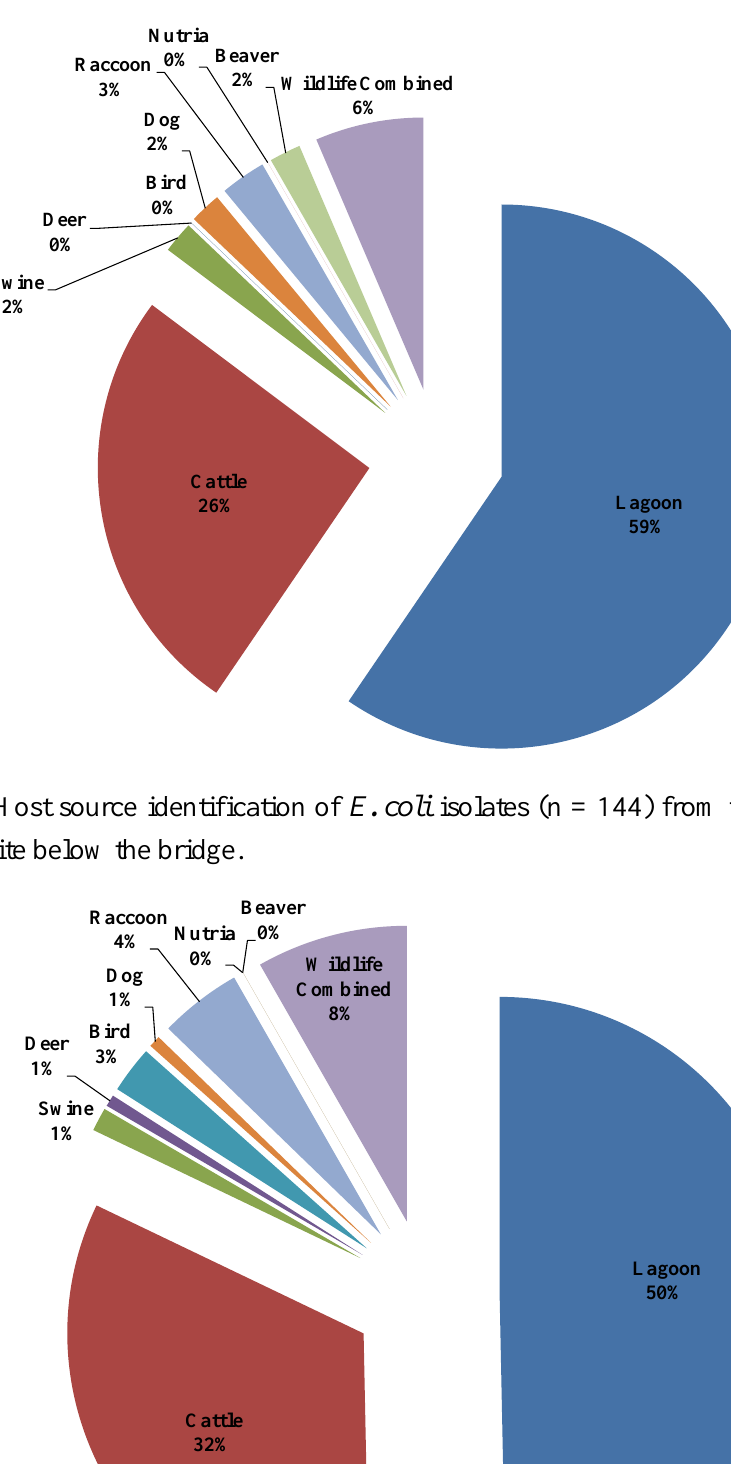
Figure 2. Host source identification of E. coli isolates (n = 102) from the Six Runs Creek sampling site above the bridge.